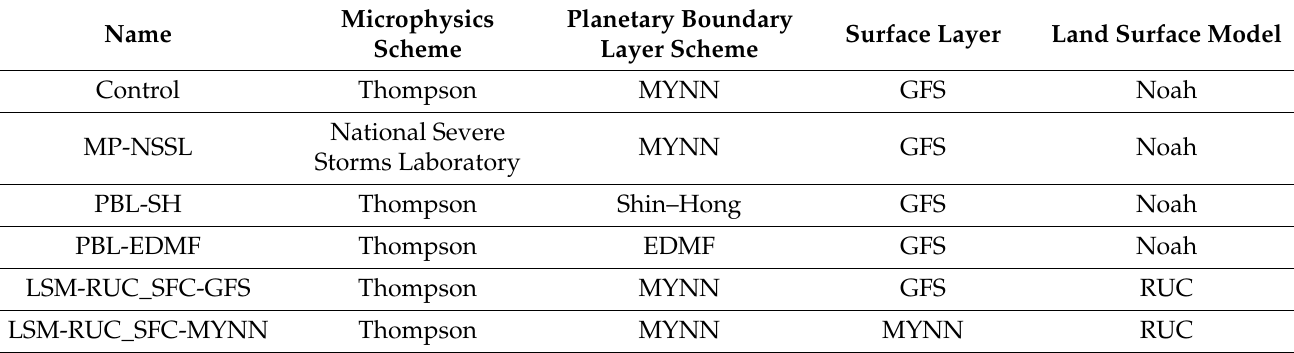
Table 1. Description of model configurations for the 2019 HWT dataset used in this analysis.